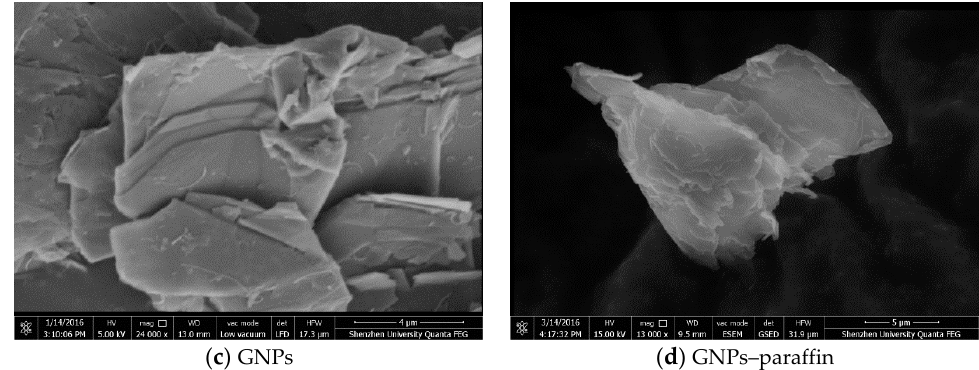
Figure 4. SEM micrographs of ( a ) Expanded graphite (EG); ( b ) EG–paraffin CPCM; ( c ) Graphene nanoplatelets (GNPs); ( d ) GNPs–paraffin CPCM.